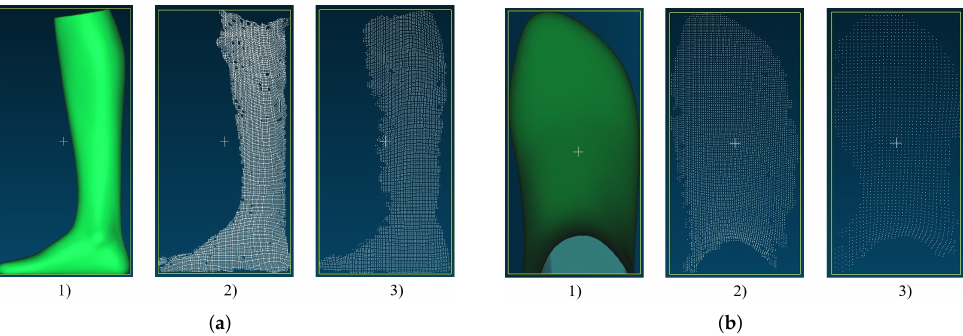
Figure 7. Example of point clouds recorded with Intel RealSense D455 SL camera: ( a ) point clouds of the foot model generated for length measurement: (1) GT, (2) length measurement (500 mm), (3) length measurement (1000 mm); ( b ) point clouds of the foot model generated for width measure- ment: (1) GT, (2) width measurement (500 mm), (3) width measurement (1000